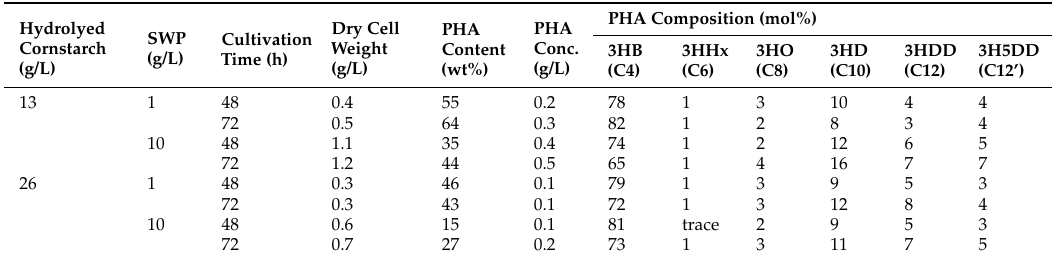
Table 6. Biosynthesis of PHA in Pseudomonas sp. 61-3 ( phbC :: tet ) harboring pJKSc54- phab from SWP and hydrolyzed cornstarch.